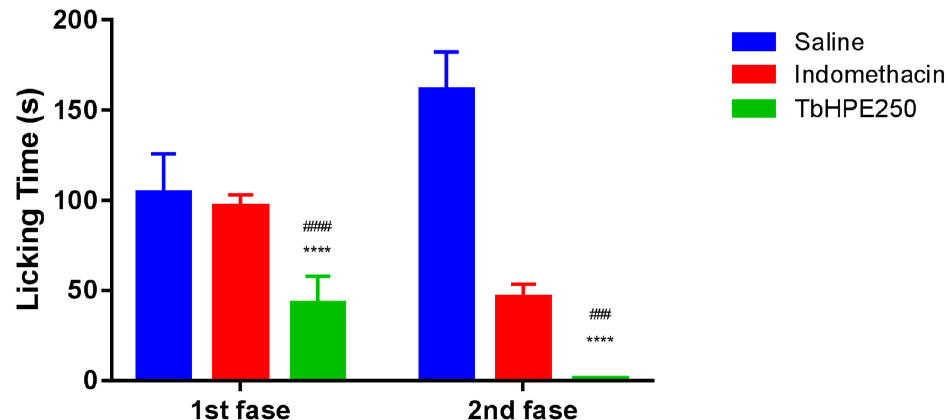
Figure 5. Effects of oral treatment with hydroethanolic pollen extract collected by Scaptotrigona affinis postica (TbHPE) on the formalin test induced administration of 2.5% formalin. Mice treated with saline, indomethacin (10 mg/kg), and TbHPE 250 mg/kg. **** p < 0.001 vs. saline; ### p < 0.005; #### p < 0.001 vs. indomethacin (ANOVA; Tukey).